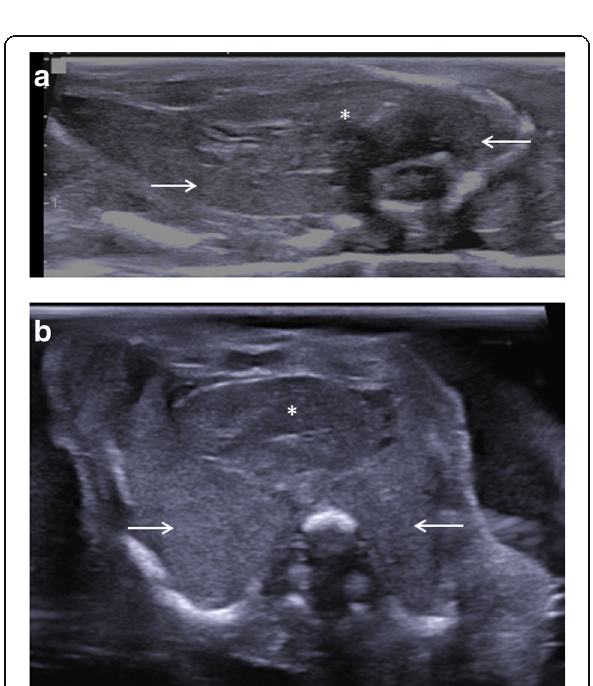
Fig. 2 Two transverse postmortem ultrasound images of the chest in the same 23-week gestational-aged foetus, obtained 4 days after death. Postmortem ultrasound performed outside the water bath ( a ) and with foetus in the water bath ( b ). Notice how the thoracic cage was collapsed both due to body laxity and transducer compression in image ( a ), but how there is improved visualisation of the heart (asterisk) and lungs (white arrows) using the water bath ( b ) as the chest